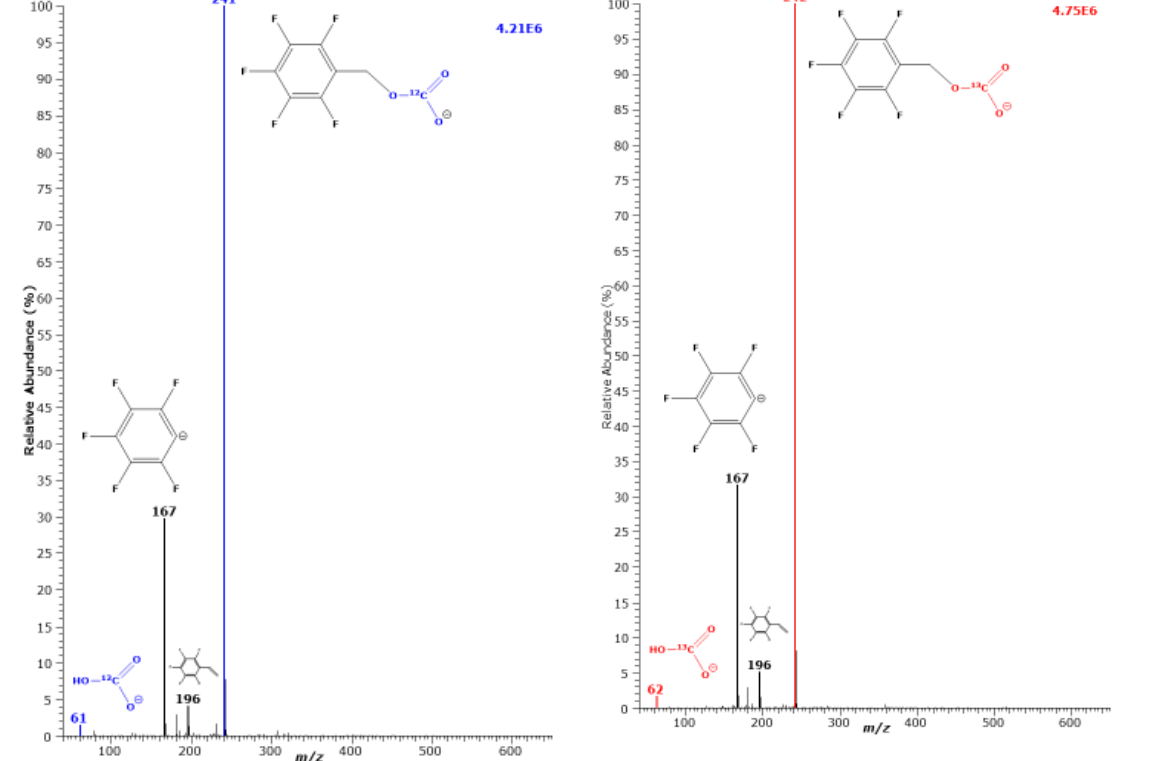
Figure 6. Negative-ion chemical ionization GC-MS spectra of PFB-O 12 COOH and PFB-O 13 COOH, two minor derivatization products from the separate reaction of 12 C- and 13 C-carbonate in aqueous acetone with pentafluorobenzyl bromide (PFB-Br) for 60 min at 50 °C. PFB-O 12 COOH (M, 242.1) and PFB-O 13 COOH (M, 243.1) have the same retention time of 6.97 min. Inserts indicate the structure of the proposed anions of 12 C-carbonate (left, blue) and 13 C-carbonate (right, red). The anions m/z 167 and m/z 196 are derived from the derivatization reagent PFB-Br. These mass spectra have been previously reported as supplementary information in Ref. [5].